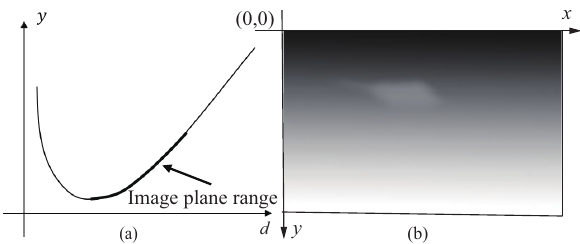
Figure 7. Illustration of the relationship between y and d : ( a ) the image of (6) and ( b ) illustrates the disparity map in the case where sea wave height is not 0 (like the target T’ shown in Figure